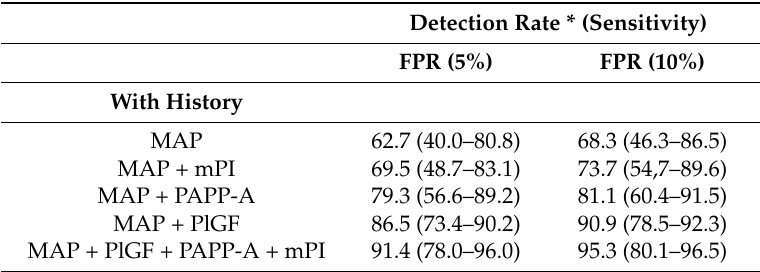
Table 5. Combination of biomarkers and detection